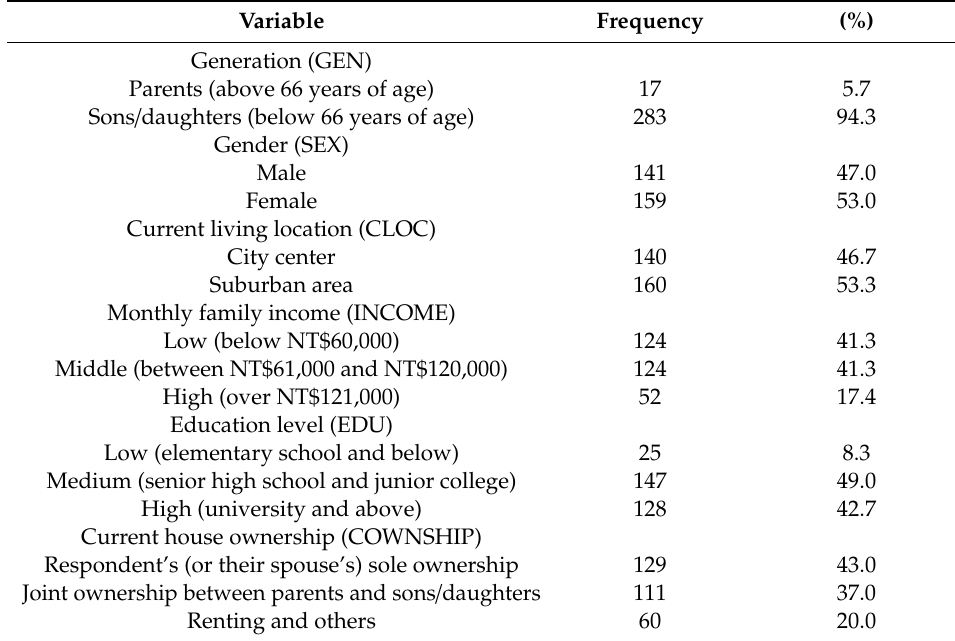
Table 2. Descriptive statistics of samples ( n =